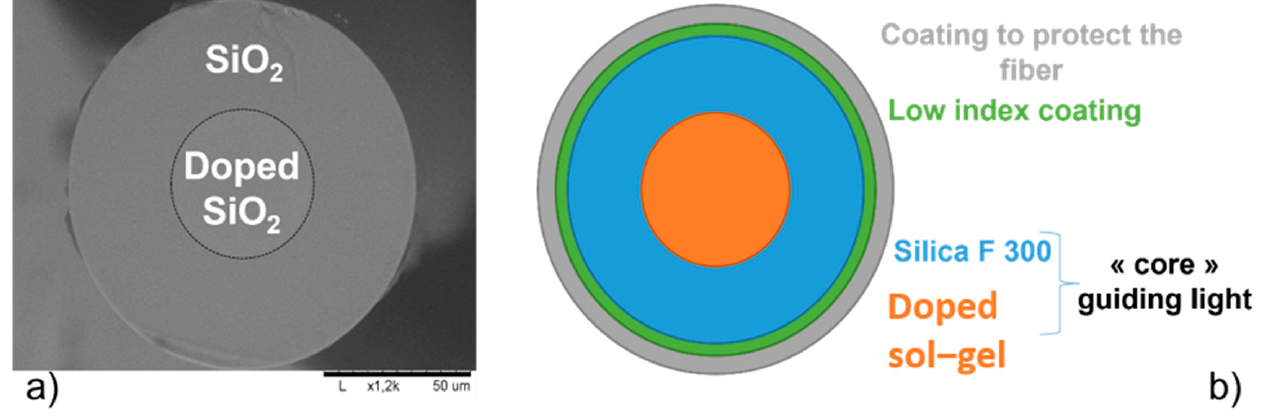
Figure 3. ( a ) SEM transverse cross-section image of the cerium-doped SiO 2 fiber core. ( b ) Cross-section scheme of the cerium-doped fiber.